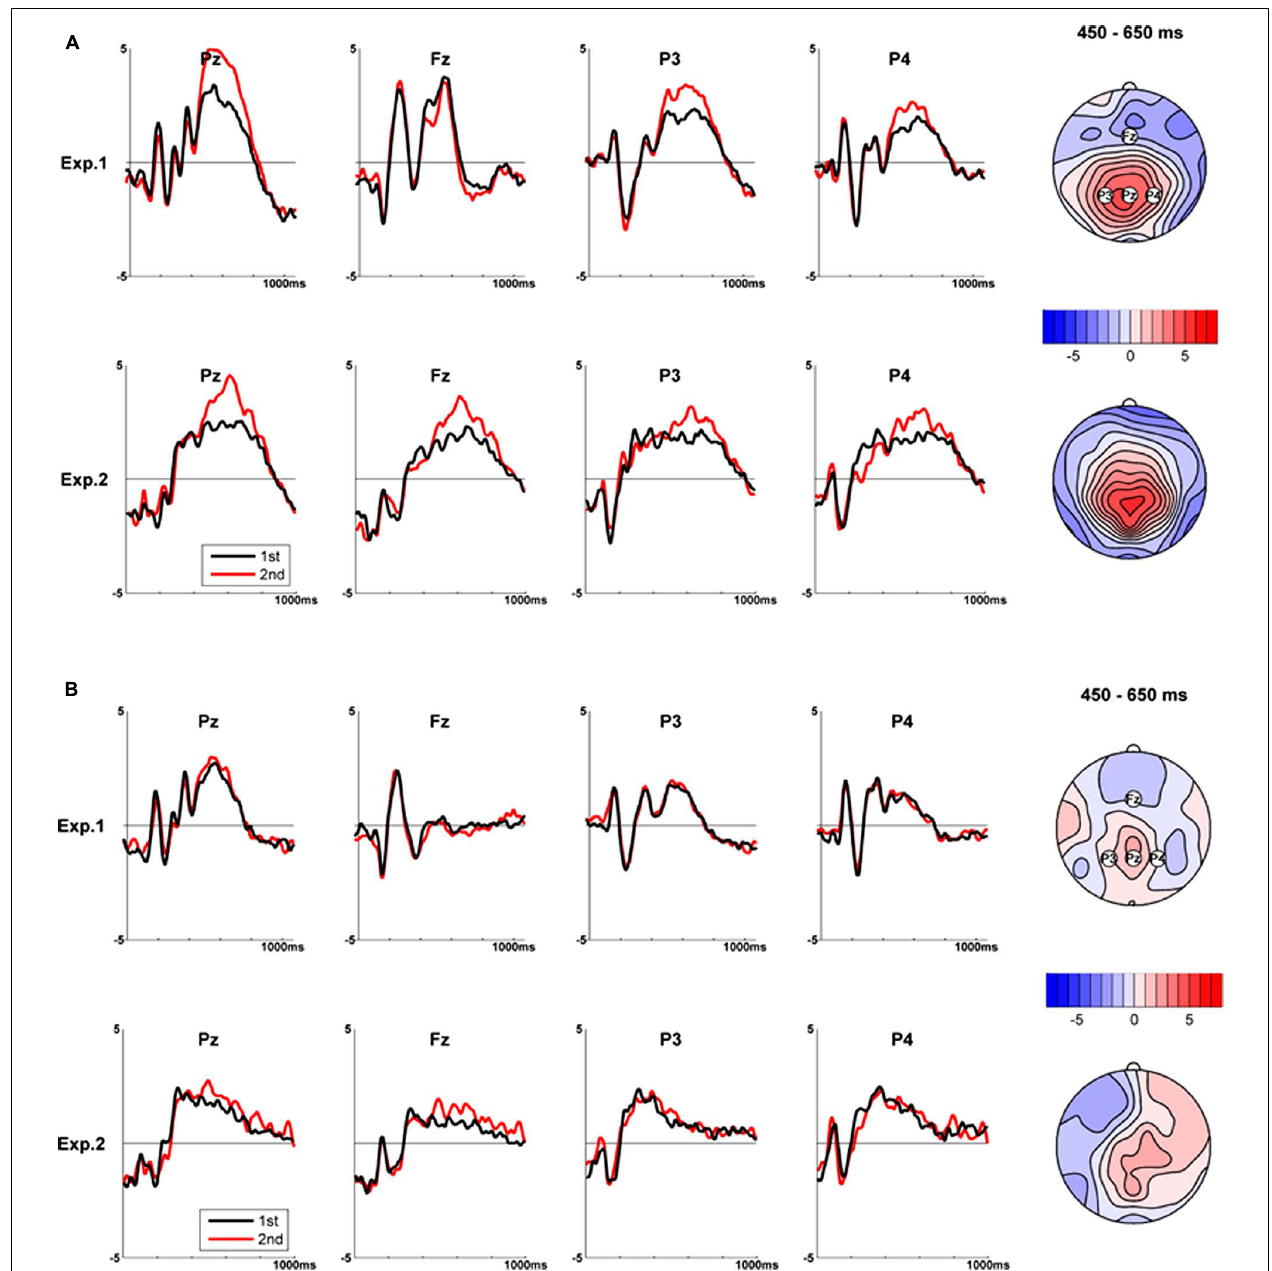
FIGURE 2 | Comparison of first versus second test halves for Experiment 1 and Experiment 2. (A) Transition effect. (B) Practice effect. Left: ERPs for prospective memory targets (A) and control items (B) from the first (black lines) and second half (red lines) at selected electrodes. Right: corresponding t -maps in the middle time window (450–650